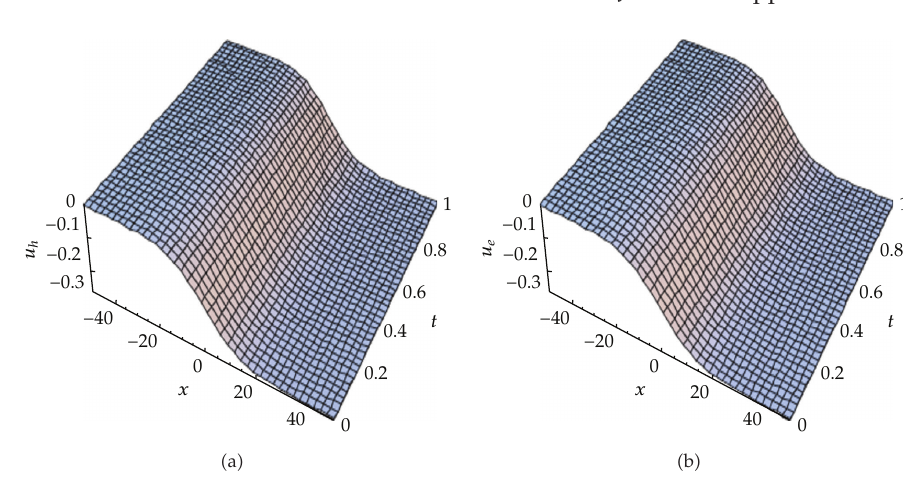
Figure 2: The approximate solution (cid:2) 5.12 (cid:3) shown in (cid:2) b (cid:3) in comparison with the exact solution (cid:2) 5.8 (cid:3) shown in (cid:2) a (cid:3) if b (cid:7) − 1 , a (cid:7) 1 ,λ (cid:7) 0 . 1, and t (cid:7) 0 .